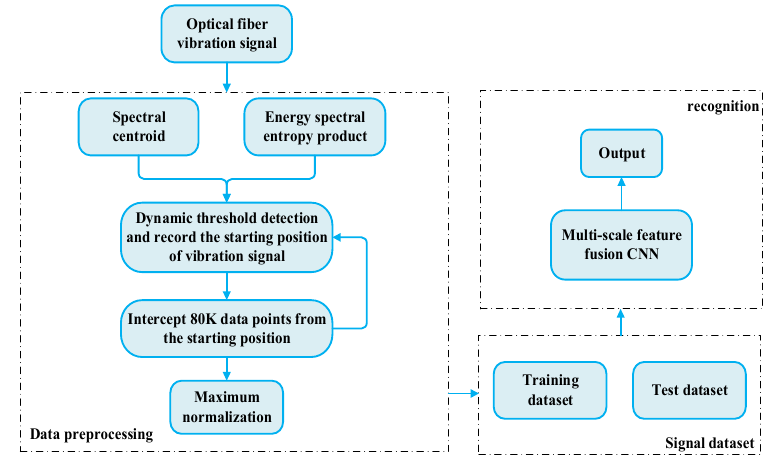
Figure 3. Overview of optical fiber vibration signal preprocessing method.